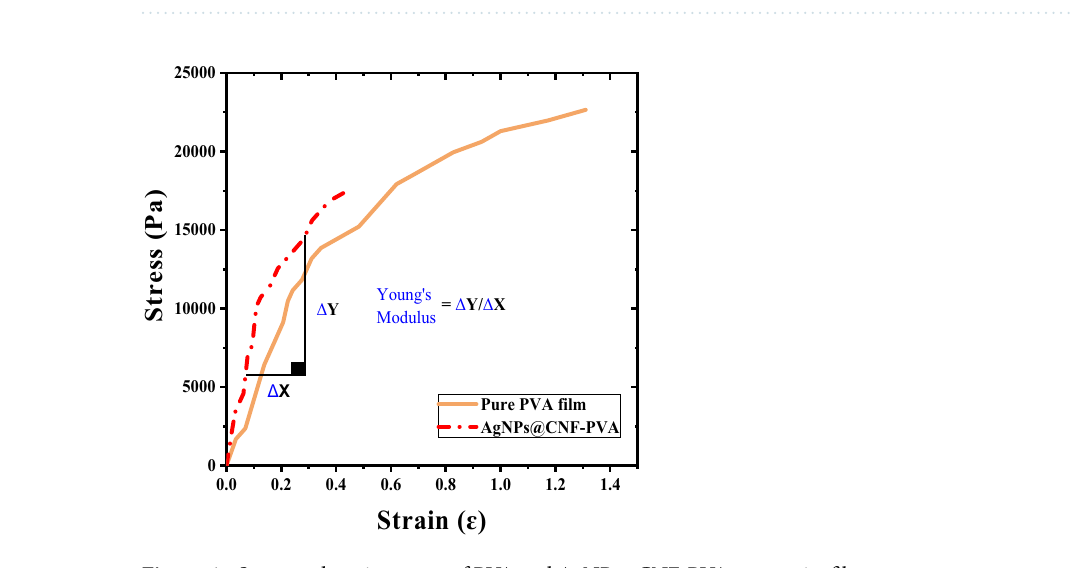
Figure 6. Stress and strain curves of PVA and AgNPs@CNF-PVA composite